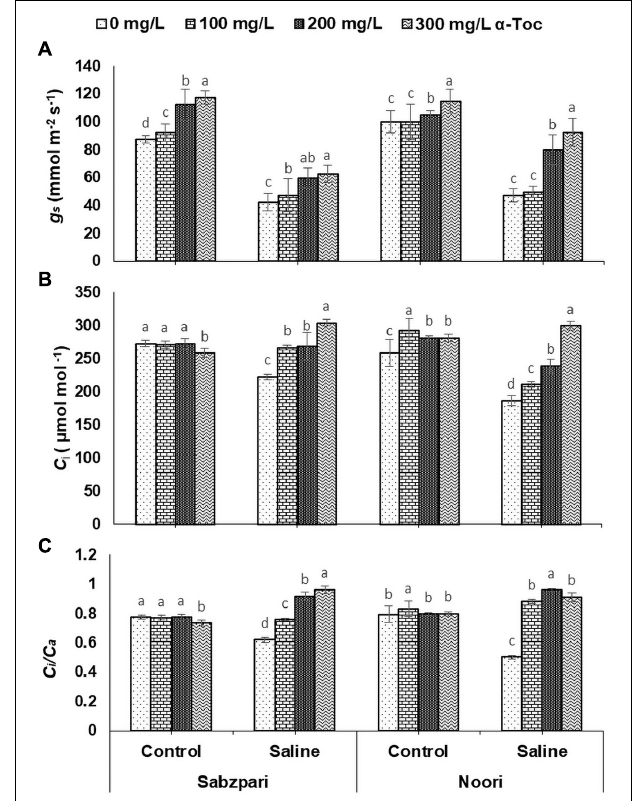
FIGURE 6 | Stomatal conductance g s (A) , Internal CO 2 concentration C i (B) C i / C a (C) of okra varieties sprayed with different levels of α -tocopherol under saline conditions. Values represent means ± S.D. Significant differences among row spacing were measured by the least significant difference (LSD) at p > 0.05 and indicated by different letters.